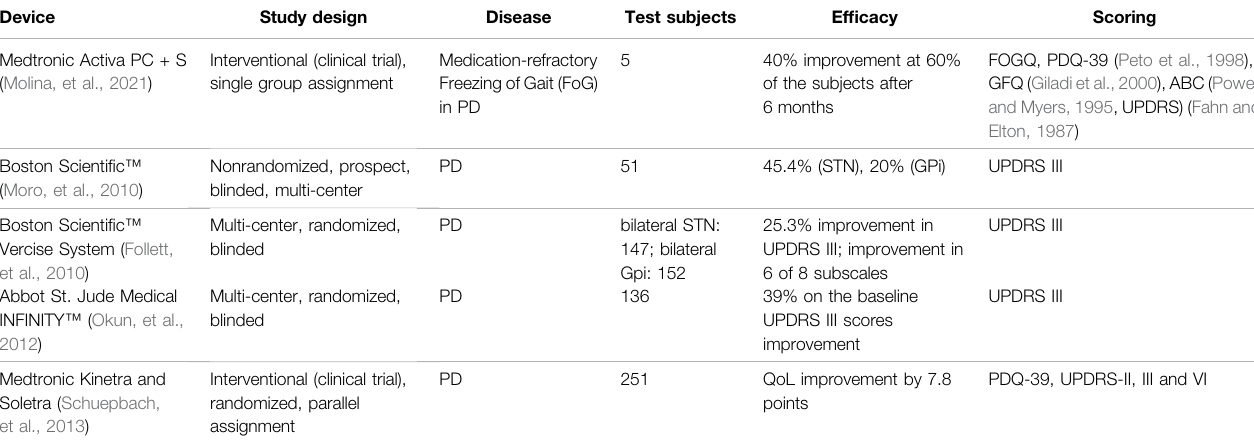
TABLE 4 | Ef fi cacy of some commercial IPG devices based on independent clinical